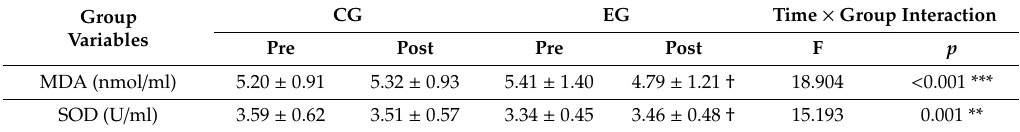
Table 4. Change in oxidative stress biomarkers over the 16-week intervention.